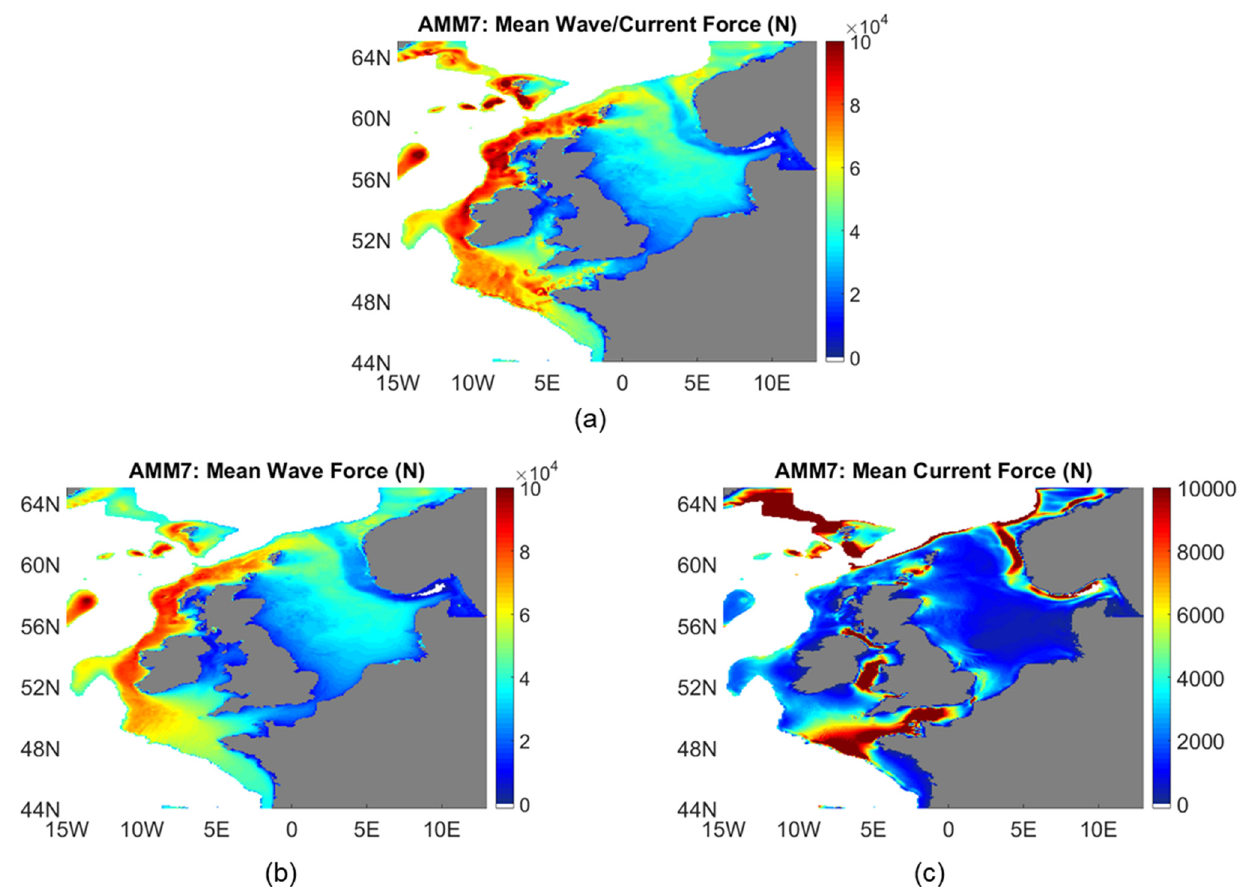
Figure 3. Spatial maps of temporal mean wave/current force ( a ), wave force ( b ), and current force ( c ), on a pile of diameter D = 1 m, deployment depth up to 500 m, from Met Office FOAM and WaveWatch III model outputs on the AMM7 grid over period July 2014 to June 2016.